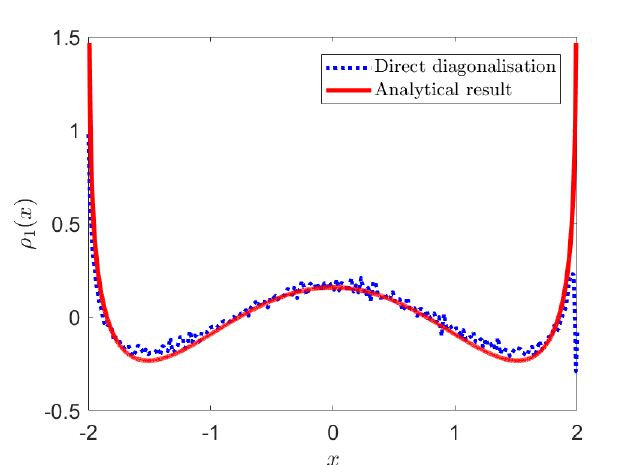
( x ) found in Eq. (128) to the average spectral 1 (cid:112) (cid:112) ( K ) = 1 δ + 1 δ K K ,1 / c K , − 1 / c 2 2 ( x ) in Eq. (126) has been removed from 0